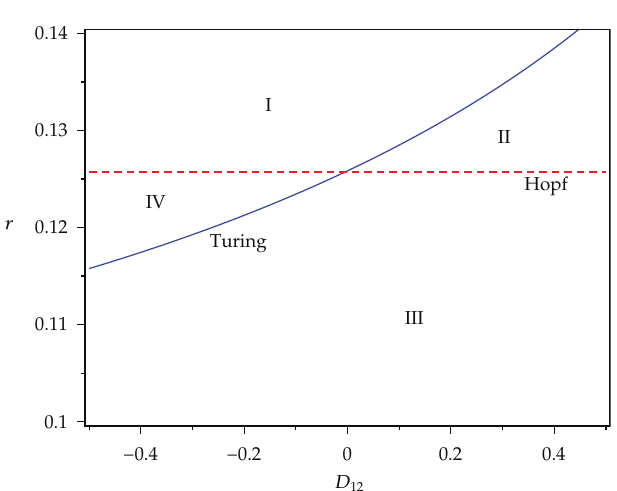
(cid:9) 12 (cid:6) 0 . 12572. H